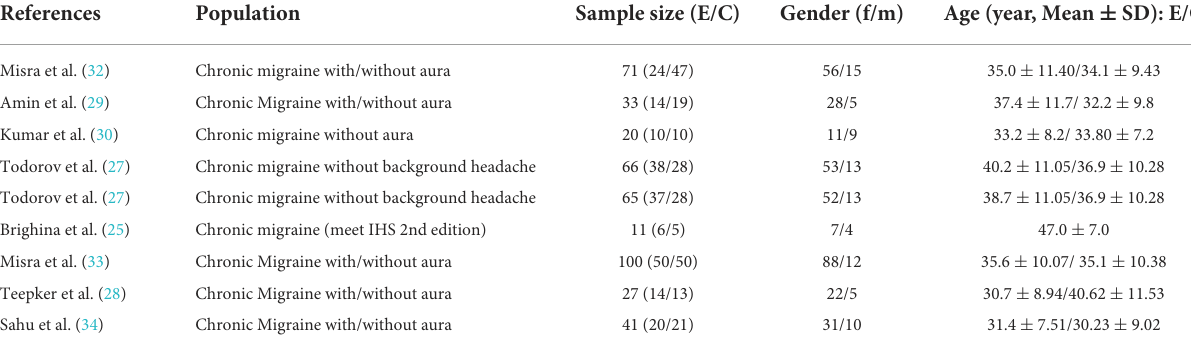
TABLE 2 Demographic characteristics of